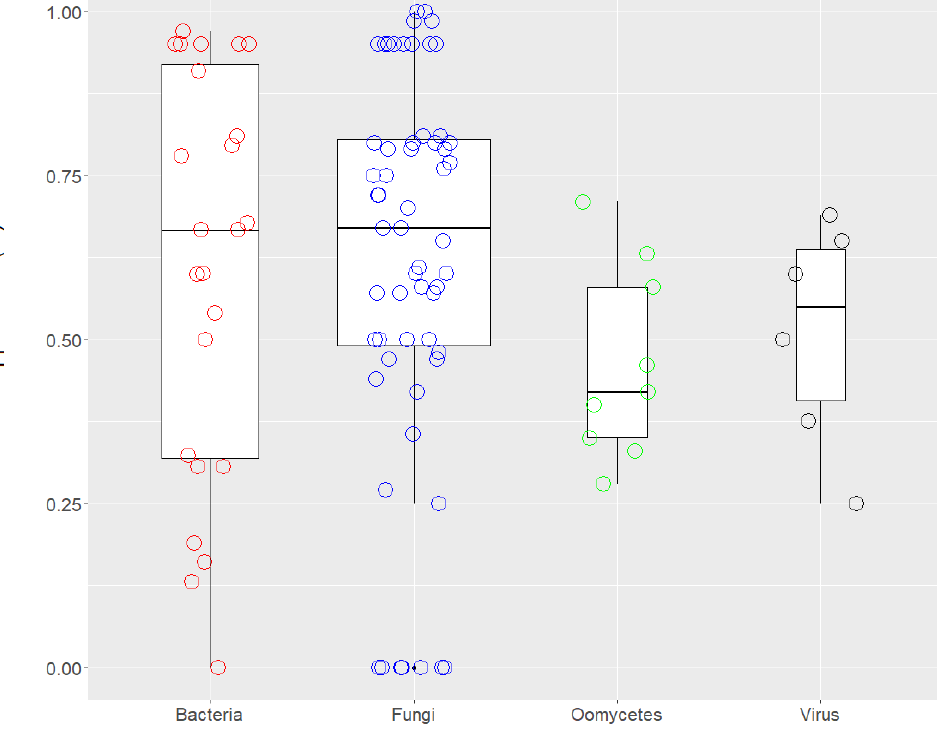
Figure 3. Jitter box plots of the disease-suppression rate against bacterial, fungal, oomycete, and viral pathogens. The lower and upper bounds of the boxplots show the first and third quartiles (the 25th and 75th percentiles); the middle line shows the median; whiskers above and below the boxplot indicate the interquartile range.